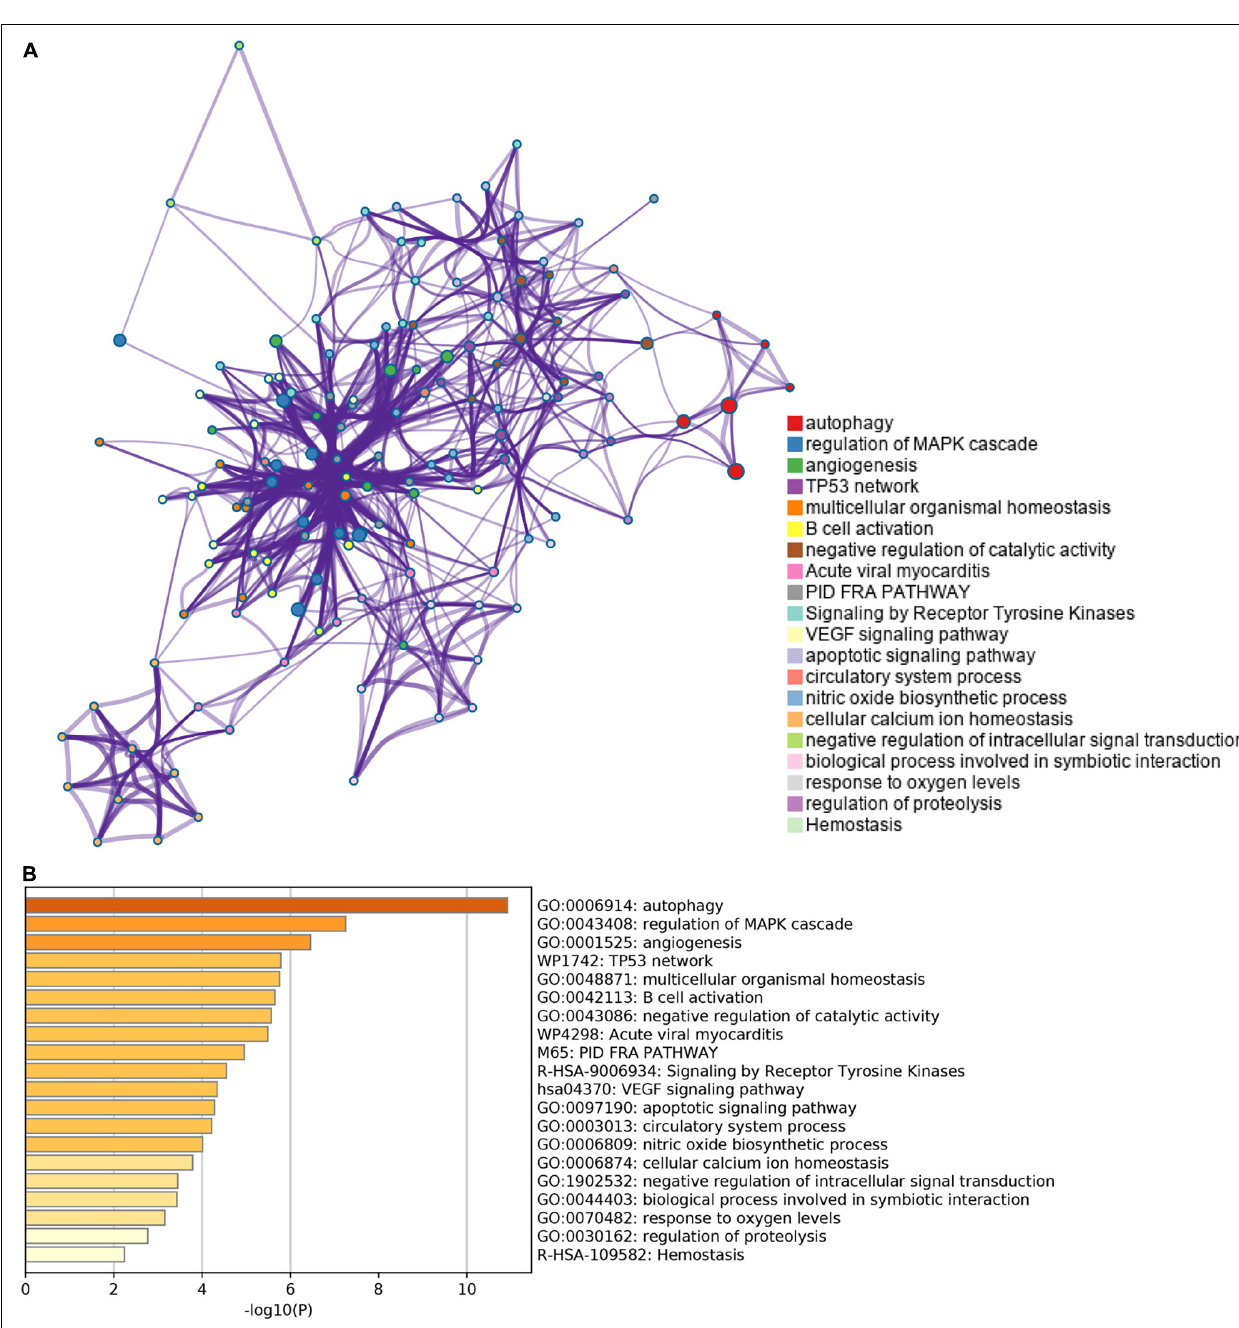
FIGURE 5 | The enrichment pathway analysis of autophagy-related DEGs. (A) The pathways network of autophagy-related DEGs using Metascape. (B) The enrichment pathway analysis of autophagy-related DEGs using Metascape.